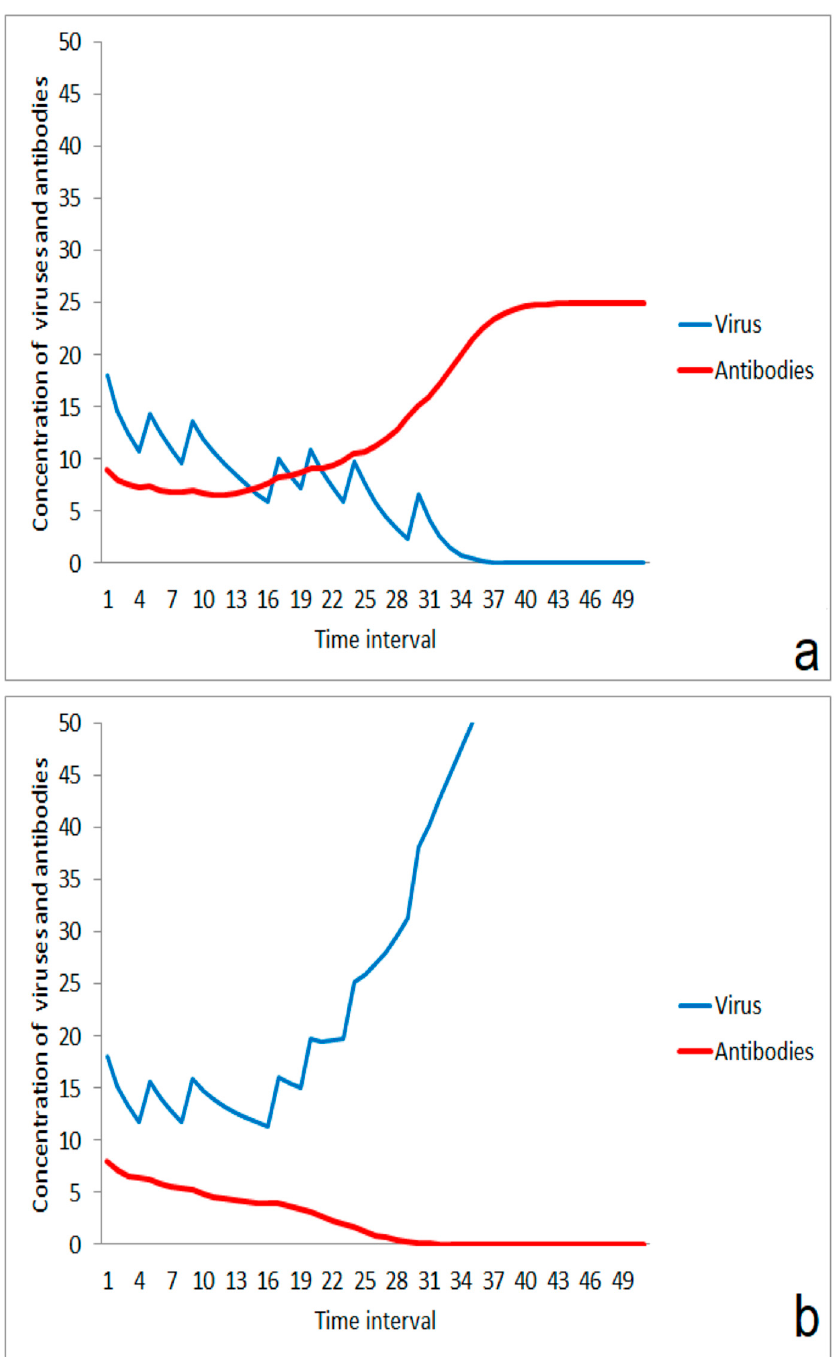
Figure 7. Multi-event stimulation of the immune system and sensitivity on start situation: ( a ) successful stimulation in case of a sufficient starting performance, ( b ) failing of the immune system after a series of moderate impact events (same impact strengths and times as in ( a )) in case of a slightly lowered starting performance of the immune system.